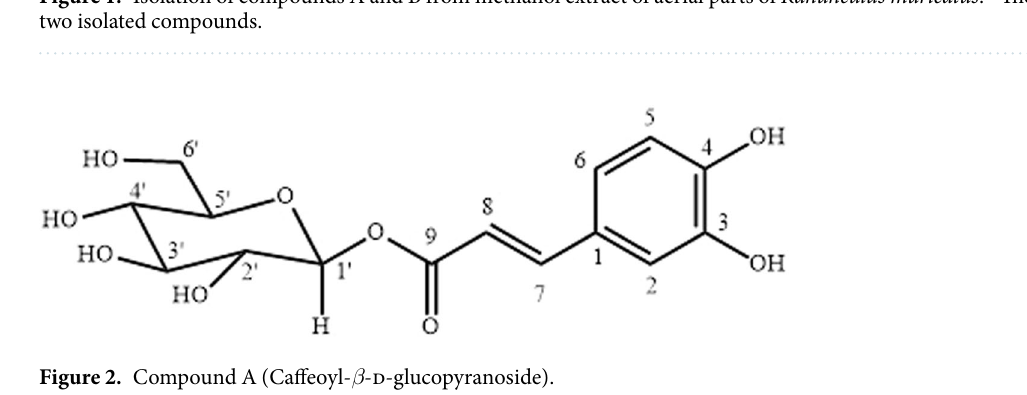
Figure 2. Compound A (Caffeoyl- β